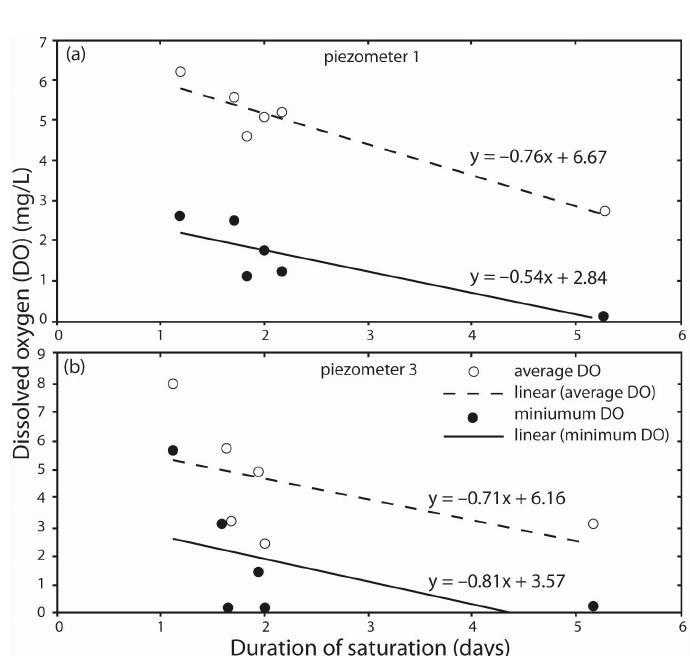
Figure 6. Average and minimum dissolved oxygen (DO) concentration (mg ∙ L ‒ 1 ) at: ( a ) piezometer 1; and ( b ) piezometer 3 as a function of duration of saturation (days) for six precipitation events between February and June 2014 (Table 1). Note that several of the DO measurements are below the MiniDOT reporting level of 0.3 mg/L (10 μ mol/L).